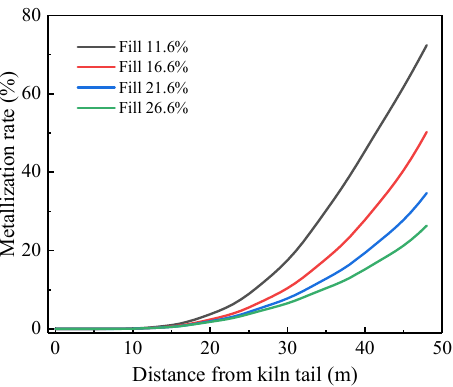
Figure 16. Metallization rate along the axial section for different fill degrees.